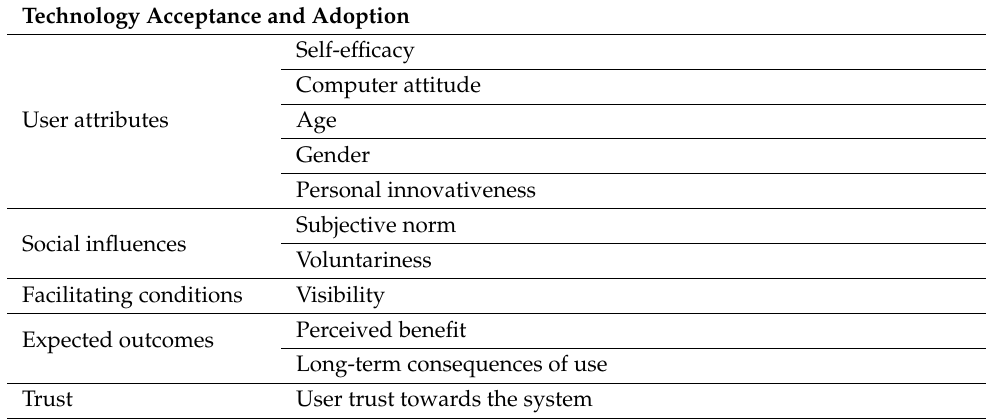
Table A2. UXIE metrics to be assessed through questionnaires before a user-based